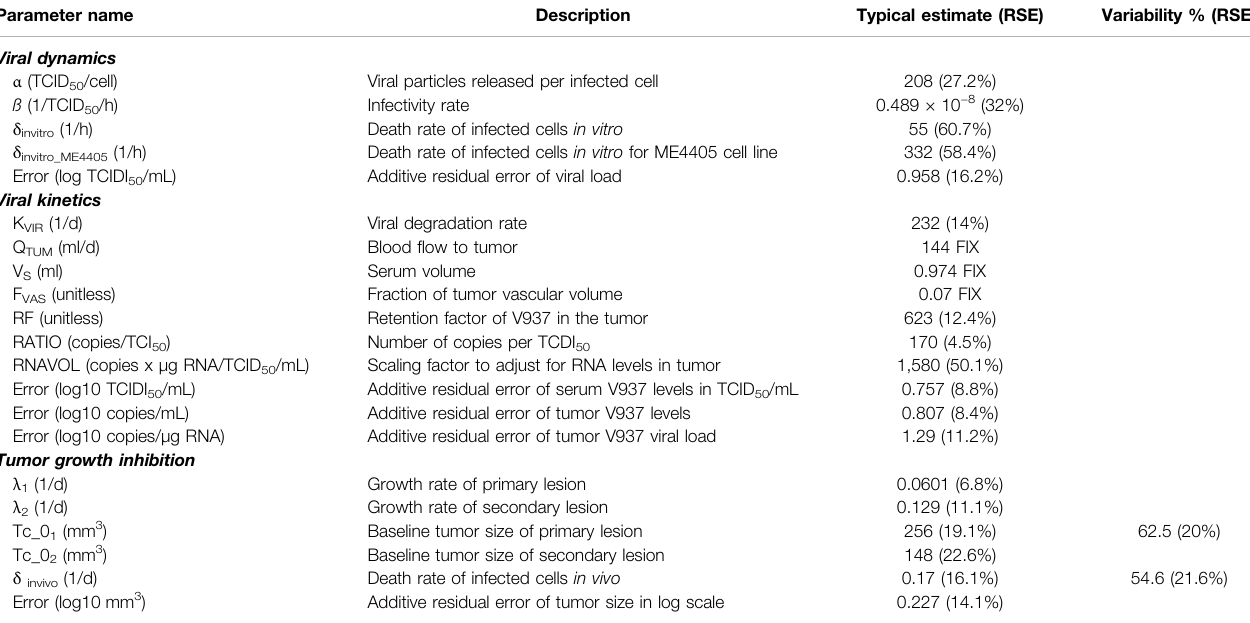
TABLE 2 | Parameter estimates of fi nal